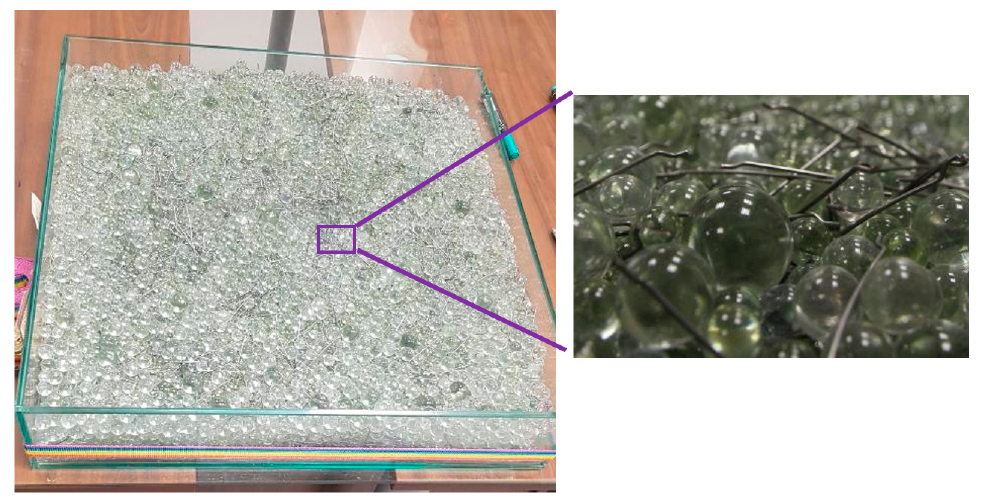
Figure 4. Simulated matrix and detail of fibre reinforced concrete.